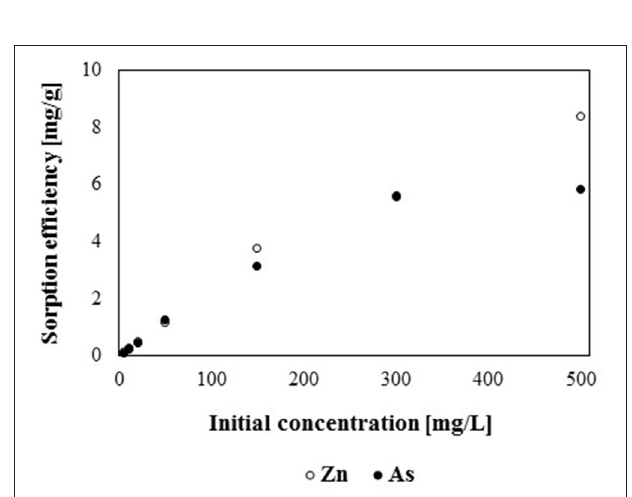
FIGURE 5 | SEM photomicrographs of the gBIOs. Upper left: cryptocrystlline iron oxyhydroxide aggregates, upper right: minute carbonate crystallites embedded within ferruginous-organic mass, lower left: large gypsum and calcite crystals within microcrystalline iron oxyhydroxide, lower right: large calcite crystals on the surface.